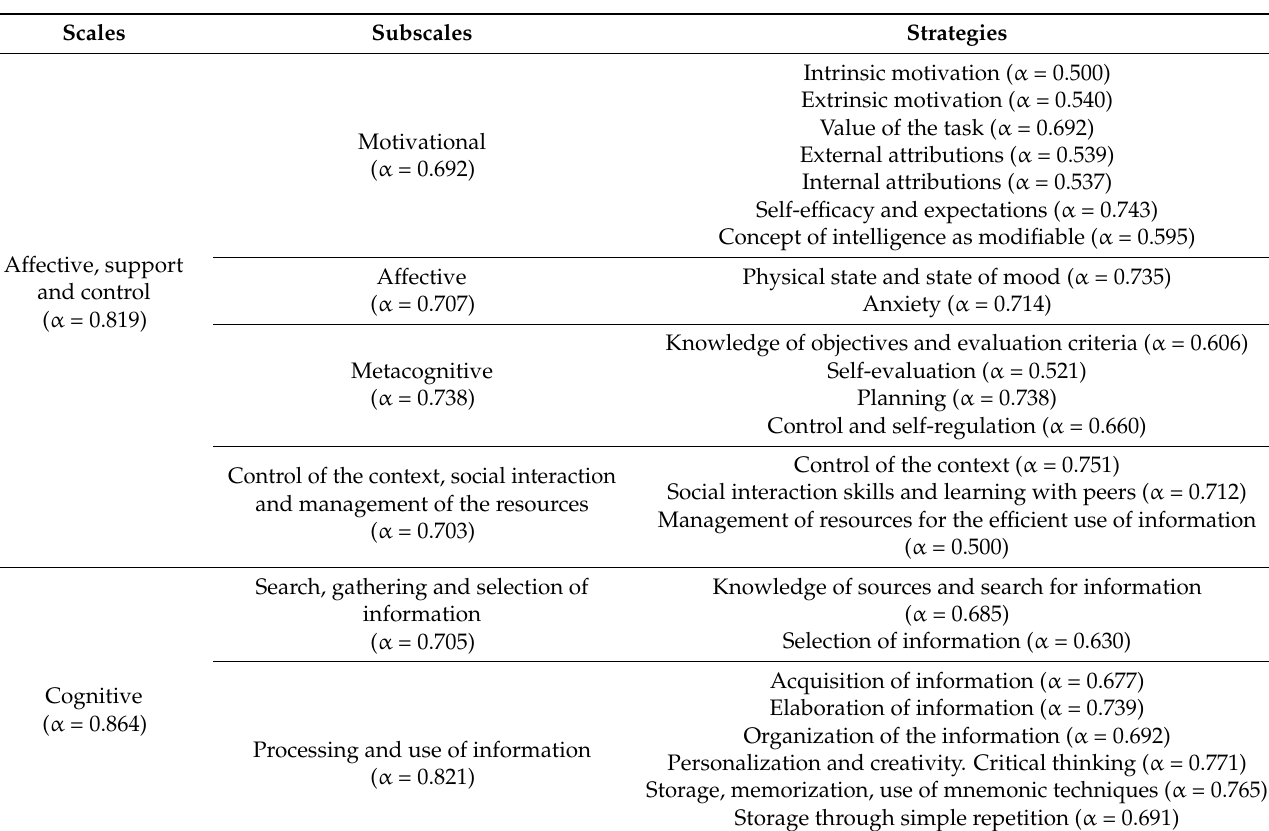
Table 1. Structure of the Questionnaire for the Evaluation of Learning Strategies of University Students (CEVEAPEU). Reliability data